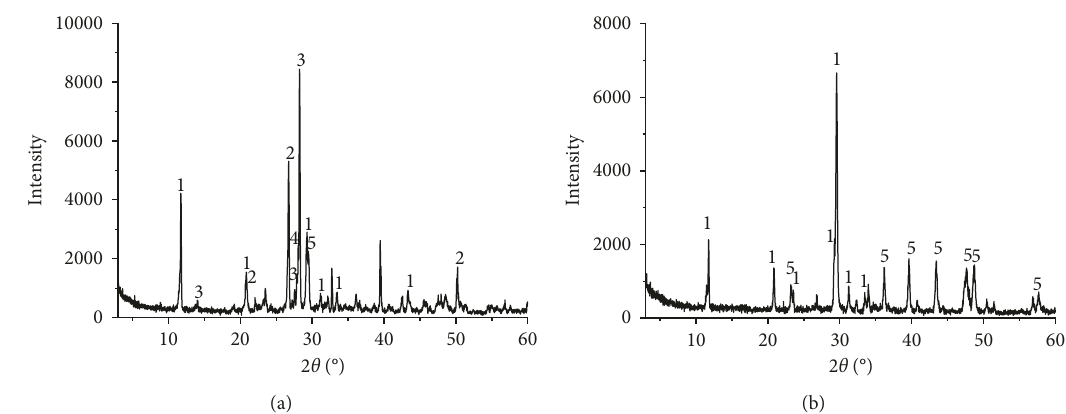
Figure 4: XRD analysis of the corroded concrete and the dense layer. (a) The corroded sidewall concrete; (b) the dense layer. 1: Gypsum; 2: quartz; 3: albite; 4: margarite; 5